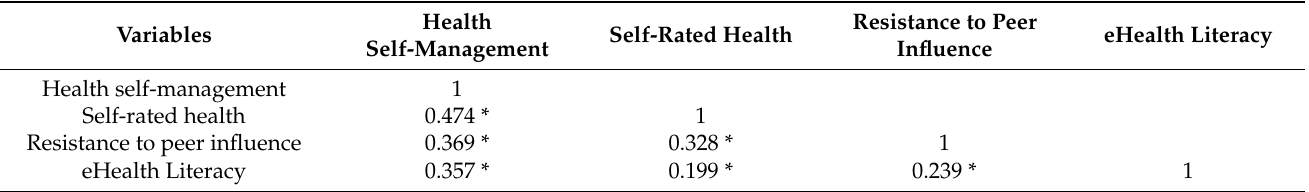
Table 2. Correlations between health self-management, resistance to peer influence, eHealth literacy and self-rated